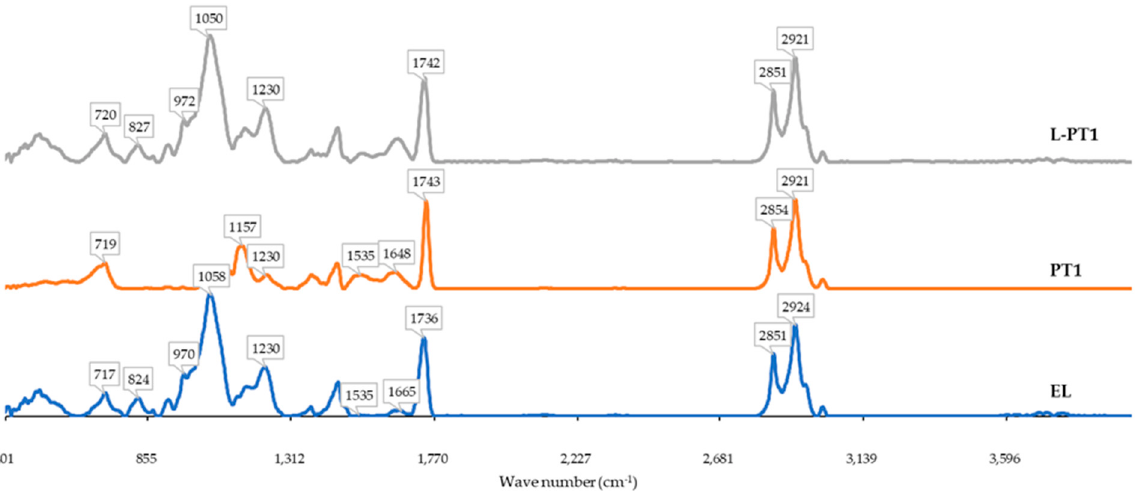
Figure 1. FTIR of empty liposome (EL), plastein hydrolysate (PH1) and plastein-loaded liposomes